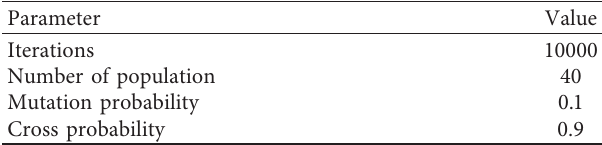
Table 7: Optimization parameters.